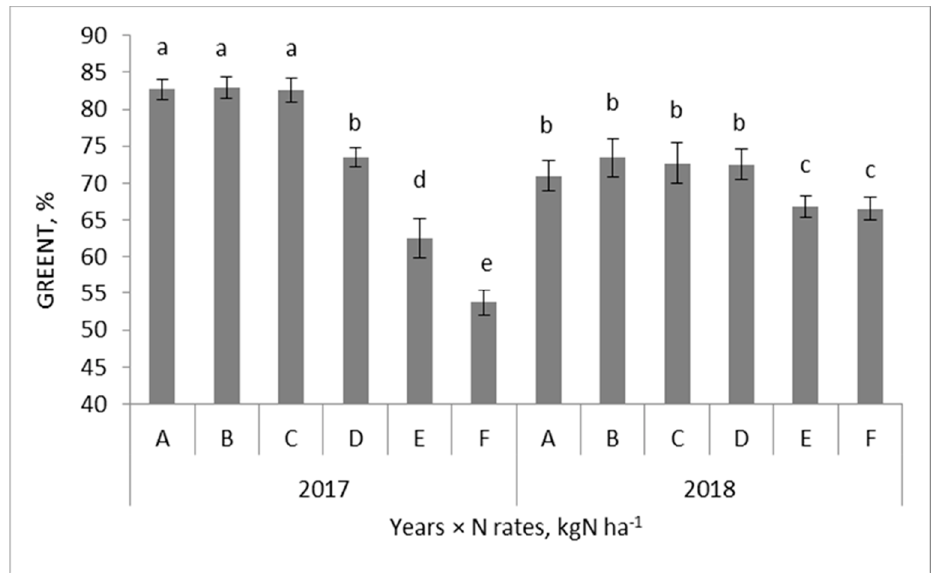
Figure A3. Effect of plant protection methods on the GREENT index of winter wheat at BBCH 75. Similar letters indicate a lack of significant differences between experimental treatments using Tukey’s test. The vertical bar in the column is the standard error of the mean.